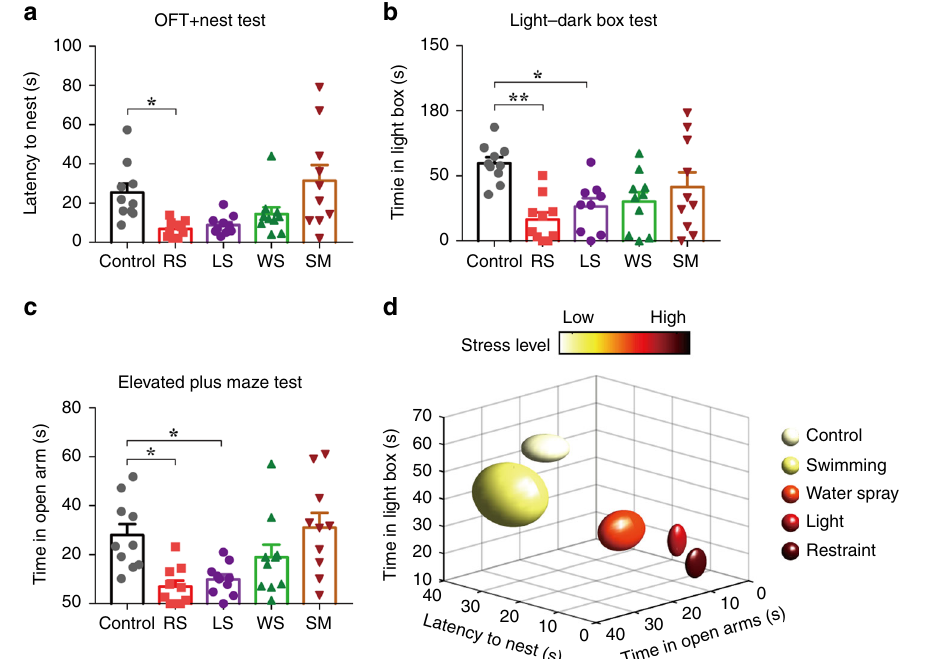
Fig. 6 Assessment of stress levels associated with different grooming models. a – c The latency to nest in open fi eld test (OFT) ( a , F (4, 45) = 5.525, P = 0.0010; Control vs. RS, * P = 0.0451), the time in light box during the light – dark box test ( b , F (4, 45) = 5.252, P = 0.0015; Control vs. RS, ** P = 0.0011; Control vs. LS, * P = 0.0137) and the time in the open arms during the elevated plus maze test ( c , F (4, 45) = 6.001, P = 0.0006; Control vs. RS, * P = 0.0113; Control vs. LS, * P = 0.0404) recorded in different models indicate signi fi cant differences mainly between the body restraint and light exposure models with the control group. n = 10 rats for each group; One-way ANOVA with Tukey post-hoc test. d 3-D plot of these parameters con fi rms that the body restraint paradigm was associated with the highest level of stress, which was followed by light exposure and water spray. Least stress was associated with free swimming and the control group. All data are presented as mean ± SEM. Source data are provided as a Source Data fi